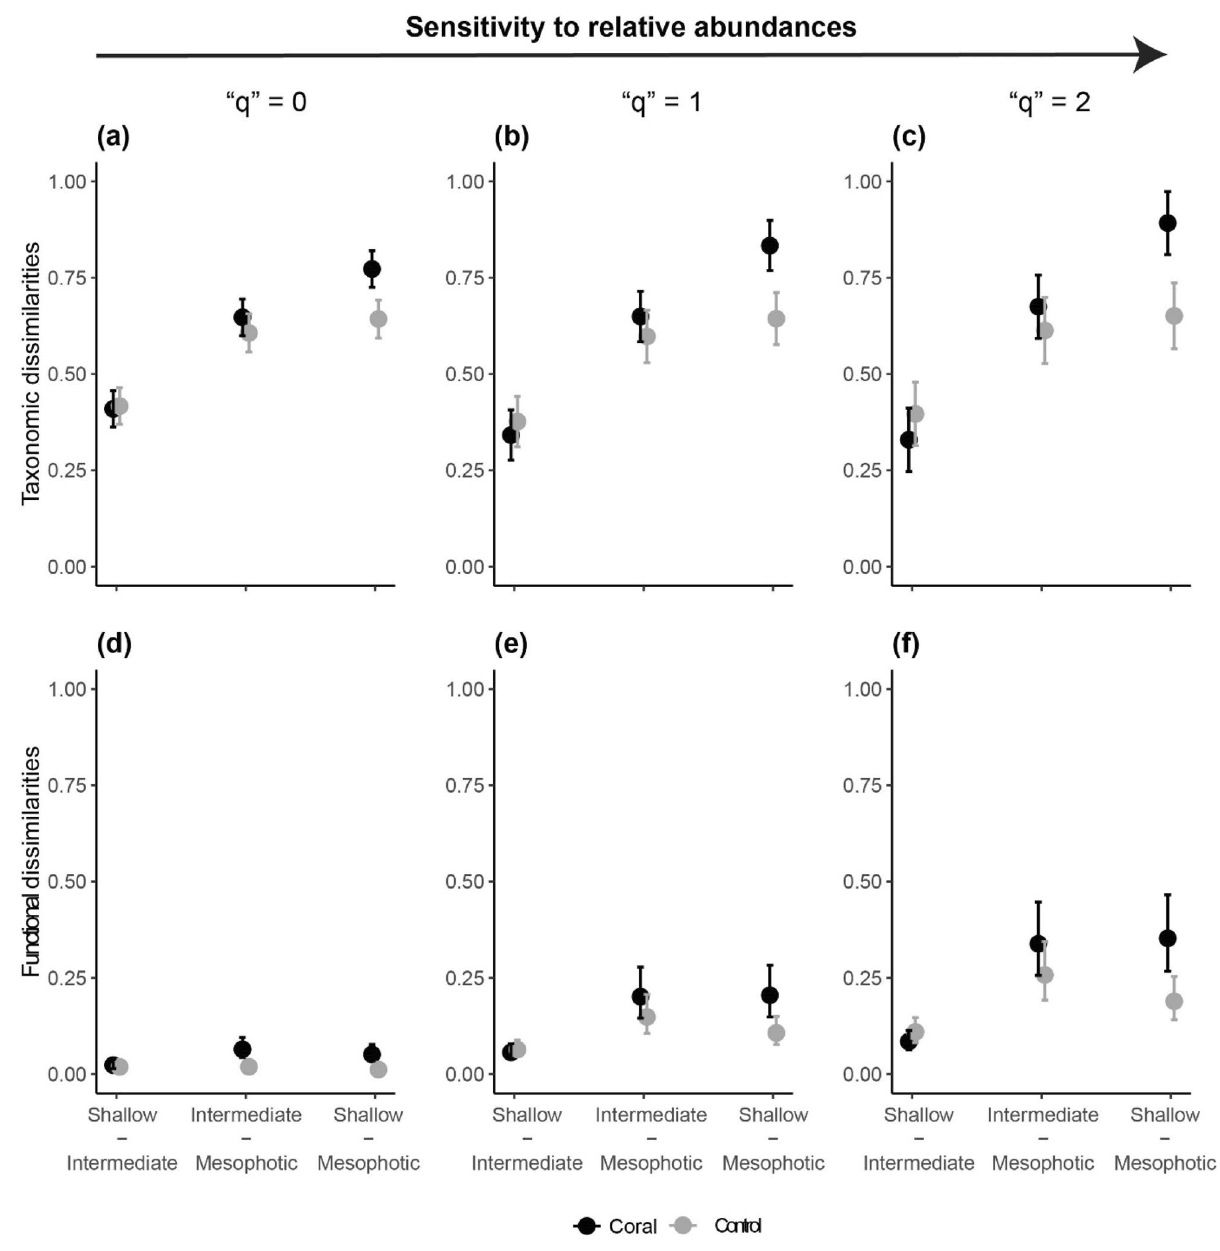
averaged predictions from GLMMs, and whiskers are standard errors around the predicted